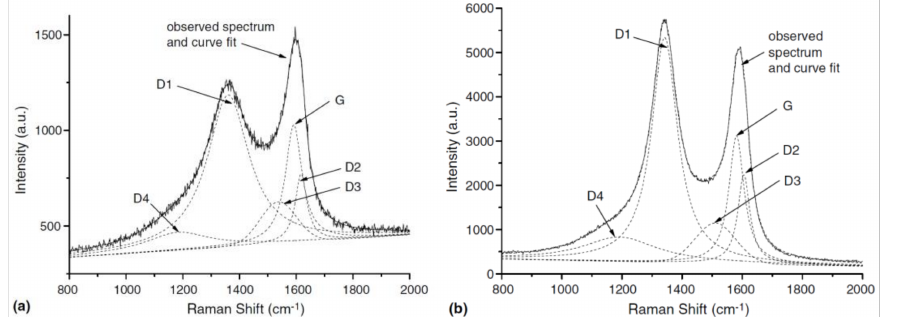
Figure 5. Peak fitting of first-order Raman spectra obtained using 514 nm laser. ( a ) Diesel soot; ( b ) Printex XE2. Reproduced with permission from Ref. [232]. Copyright © 2005